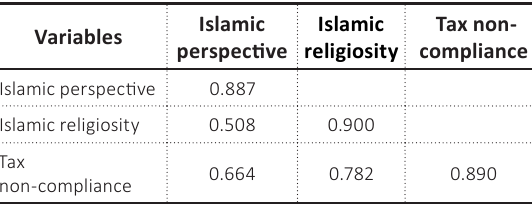
Table 3. Discriminant validity